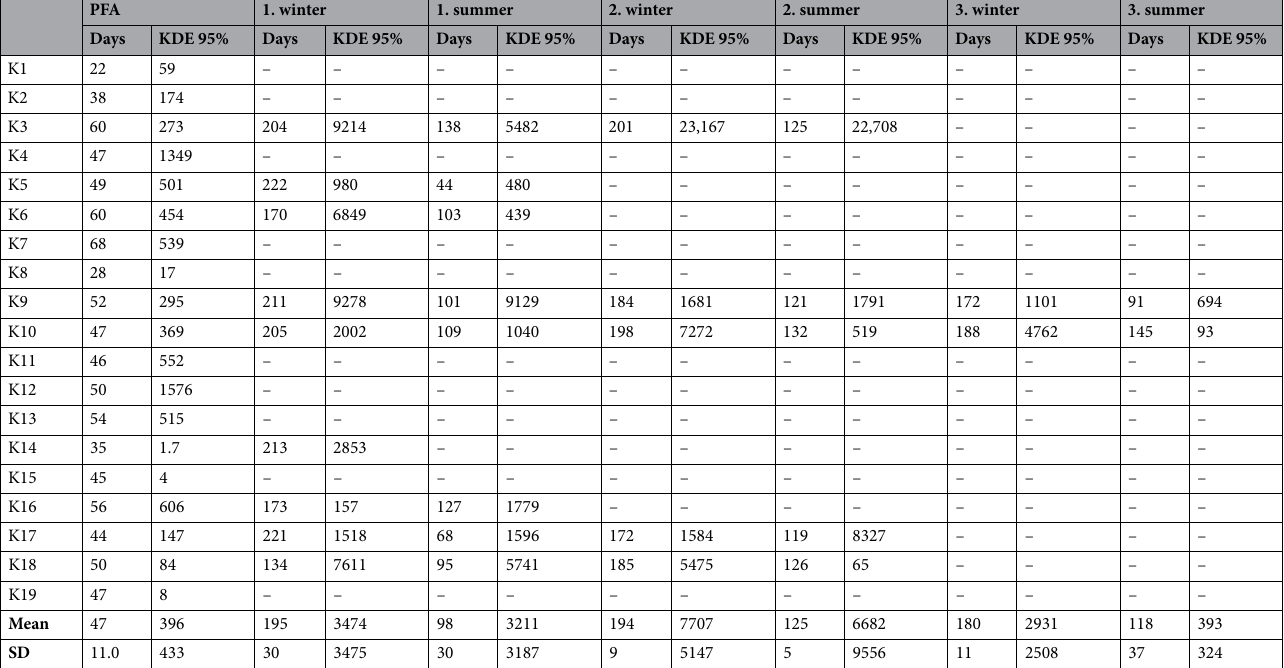
Table 5. Characteristics of post fledging area (PFA), winter and summer quaters. Kernel density etimate (KDE) are stated in km 2 .